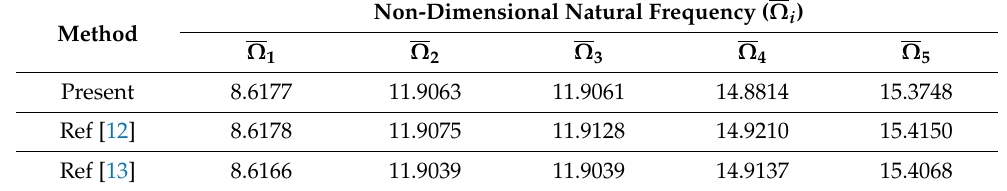
Table 3. The first five natural frequency parameters Ω i for an isotropic right triangular plate with clamped edges all